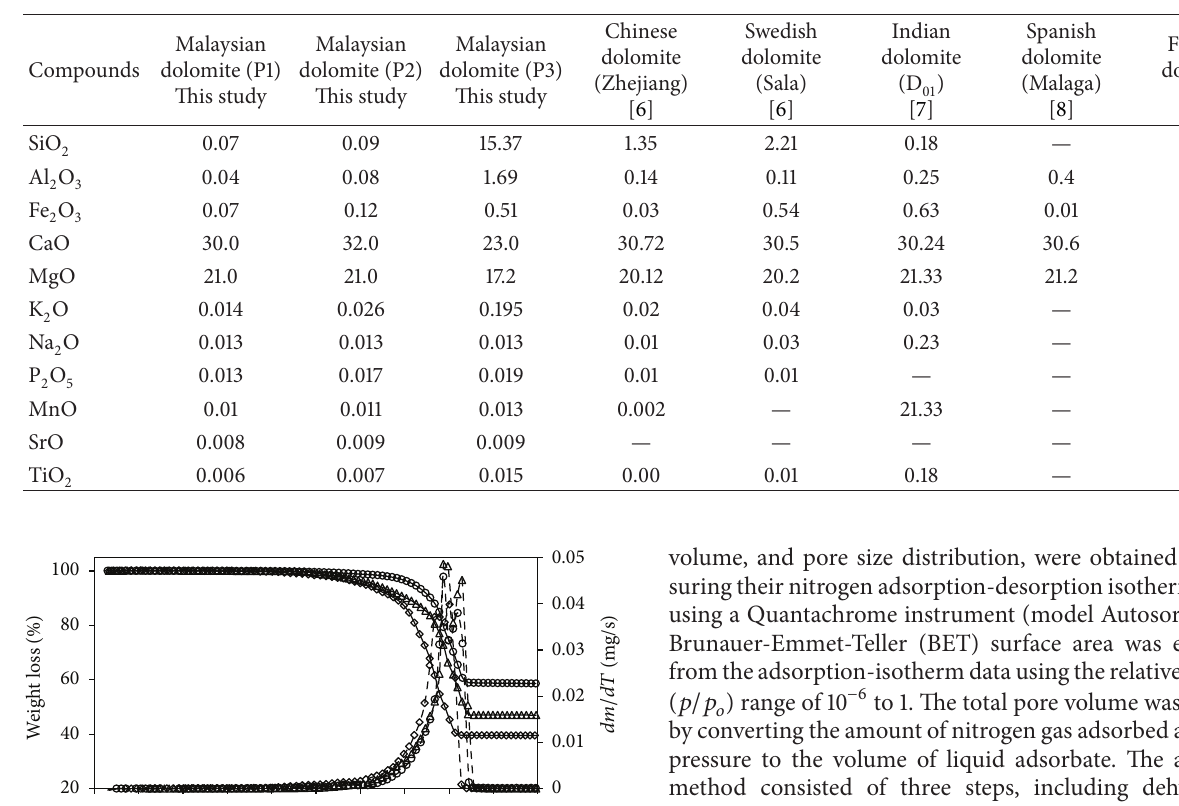
Table 1: Analysis results of the compositions of dolomite (%).